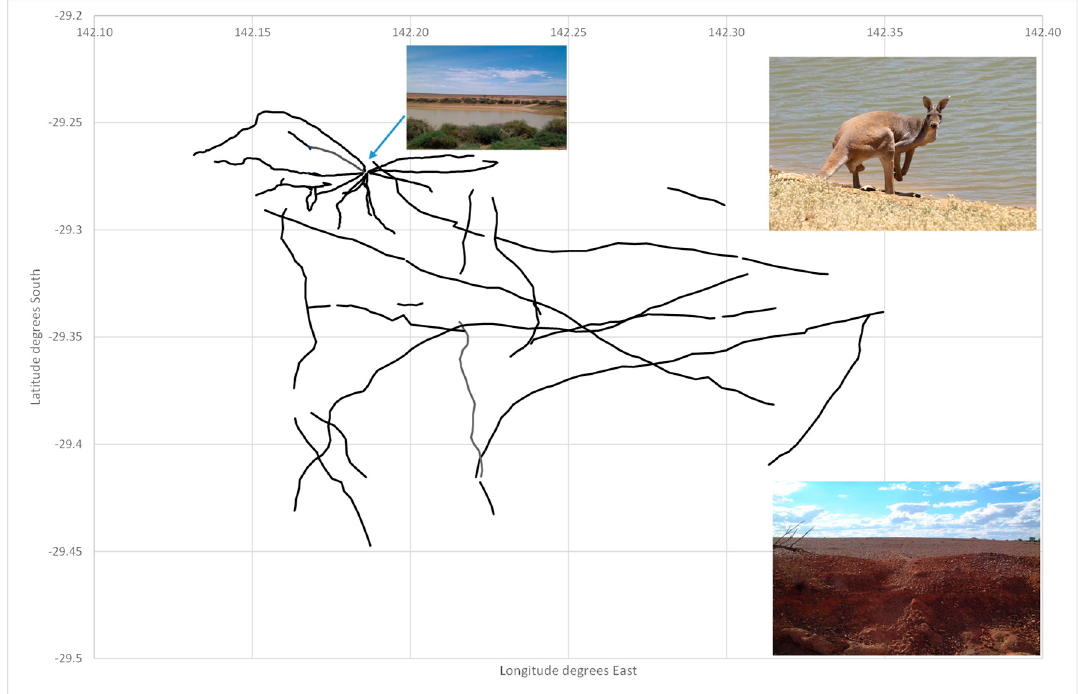
Figure 3. Map of pathways (example in lower right) created predominantly by red kangaroos (pictured in upper right) radiating from and beyond an earthen tank (pictured in upper left) on the stony downs of Sturt National Park, Australia (Images: D.B. Croft).